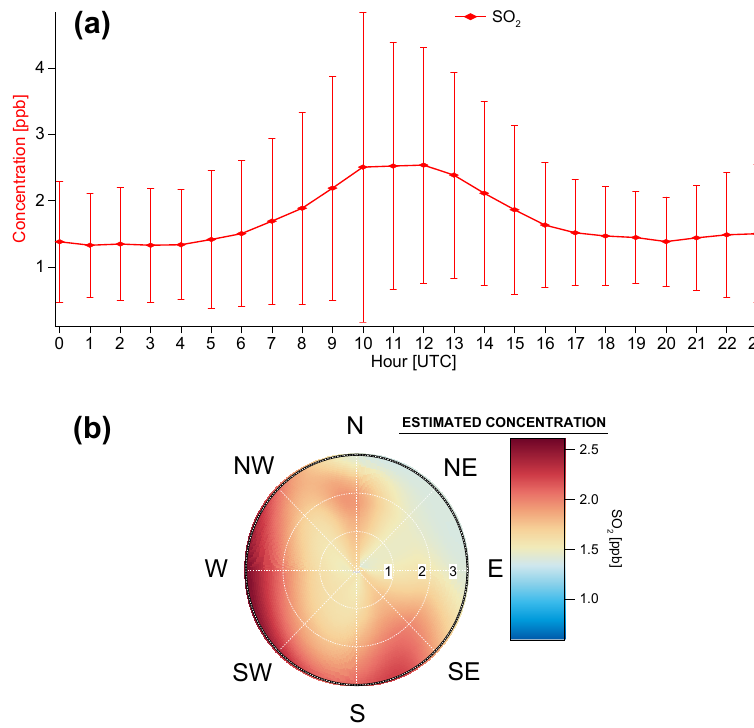
Figure 4. ( a ) Diurnal pattern computed for cold season between 1 December 2017 and 4 March 2018 for sulfur dioxide. The vertical error bars represent the standard deviation from the mean value. ( b ) Long-range transport was highlighted by NWR model for source estimation; higher concentrations were correlated with higher wind speeds. For the source estimation plots, the inner white circles represent the wind speed in m s − 1